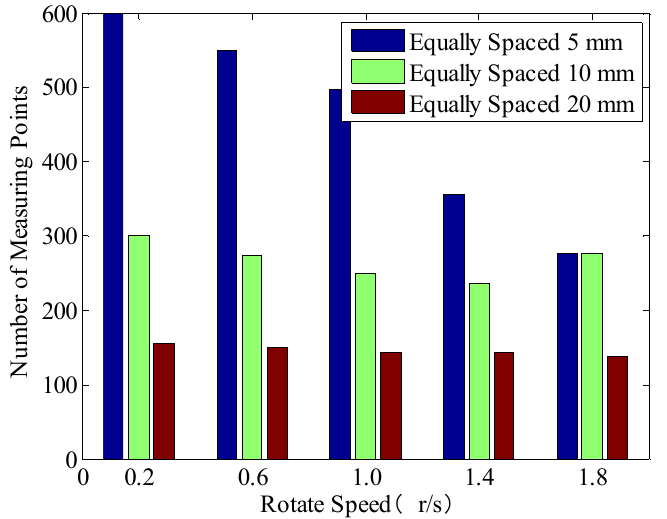
Figure 12. Relationship between speed and number of measurement points—(equally spaced).